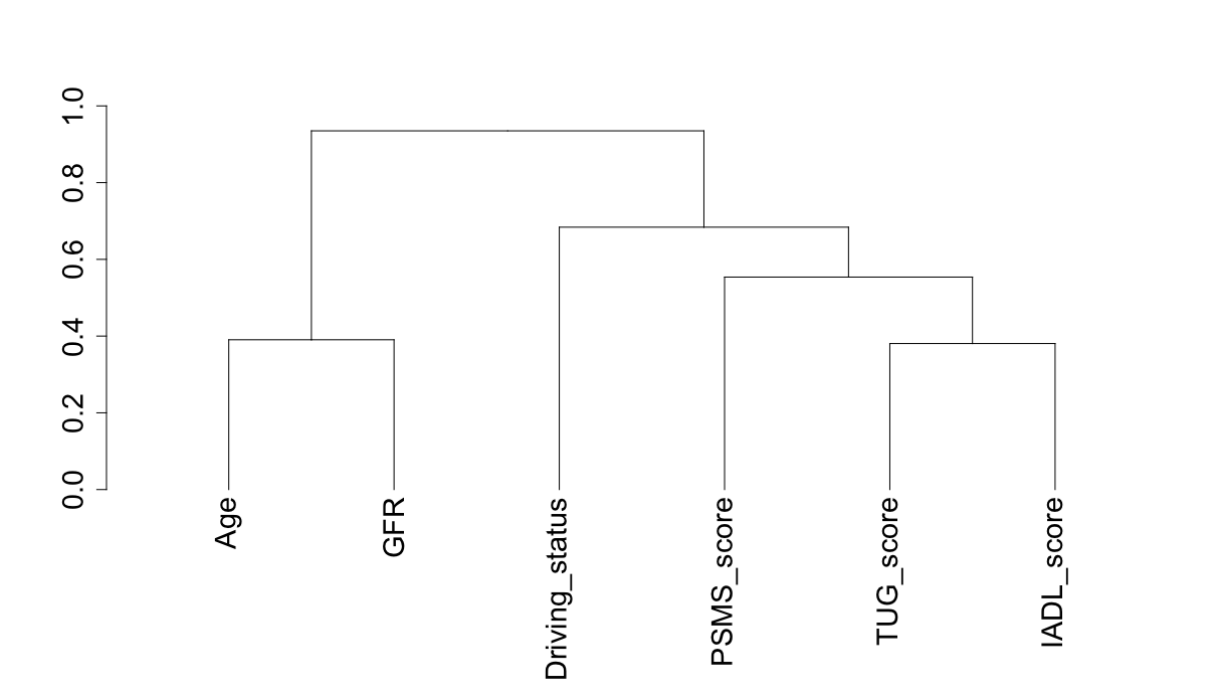
Figure 8. Hierarchical clustering of variables depicted as a dendrogram showing the close relation between a participant’s age and kidney function (glomerular filtration rate [GFR]), which together form a cluster with the physical diagnostic tests of IADL, TUG, and PSMS. The variable descriptors are as follows: age, participant’s age; GFR, kidney function; Driving_status, driving status; PSMS_score, Physical Maintenance Scale total score; TUG score, Timed Up and Go score; IADL_score, Instrumental Activities of Daily Living total